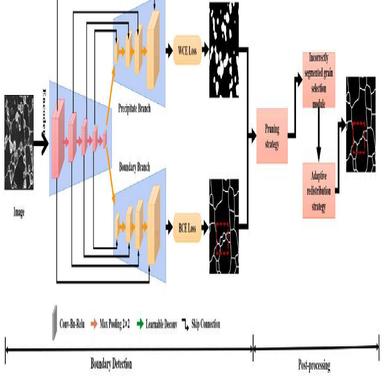
The flowchart of our the proposed MPU-Net.